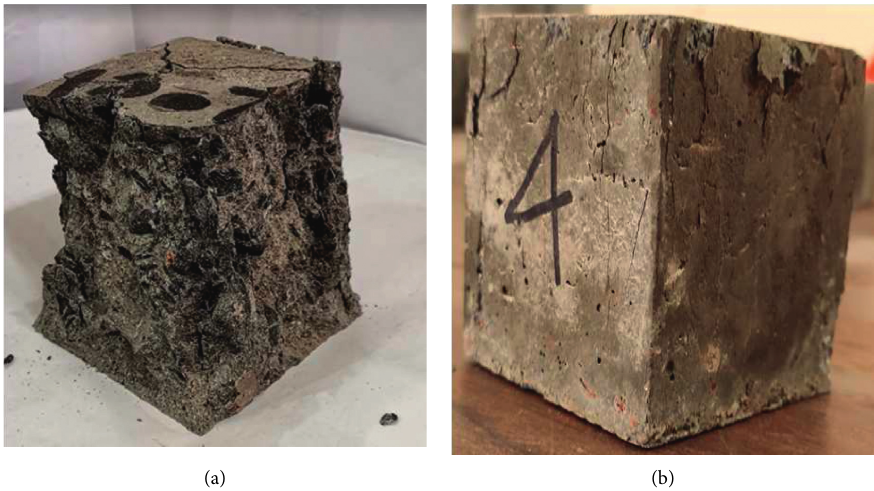
Figure 6: Compression failure. (a) Cube with 0% WSF. (b) Cube with 1% WSF.